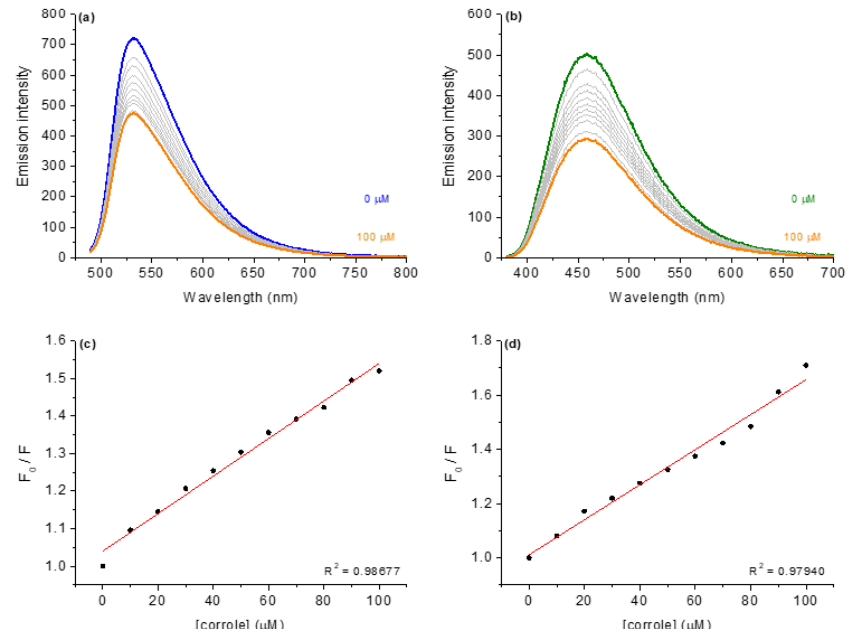
Figure 6. Steady-state fluorescence emission spectra for ( a ) AO:DNA and ( b ) DAPI:DNA without and in the presence of corrole 4 , in in DMSO(5%)/Tris-HCl pH 7.4 mixture buffered solution. Graphs ( c , d ) shows the plot F 0 /F versus [corrole]. [corrole] = 0 –100 μM.